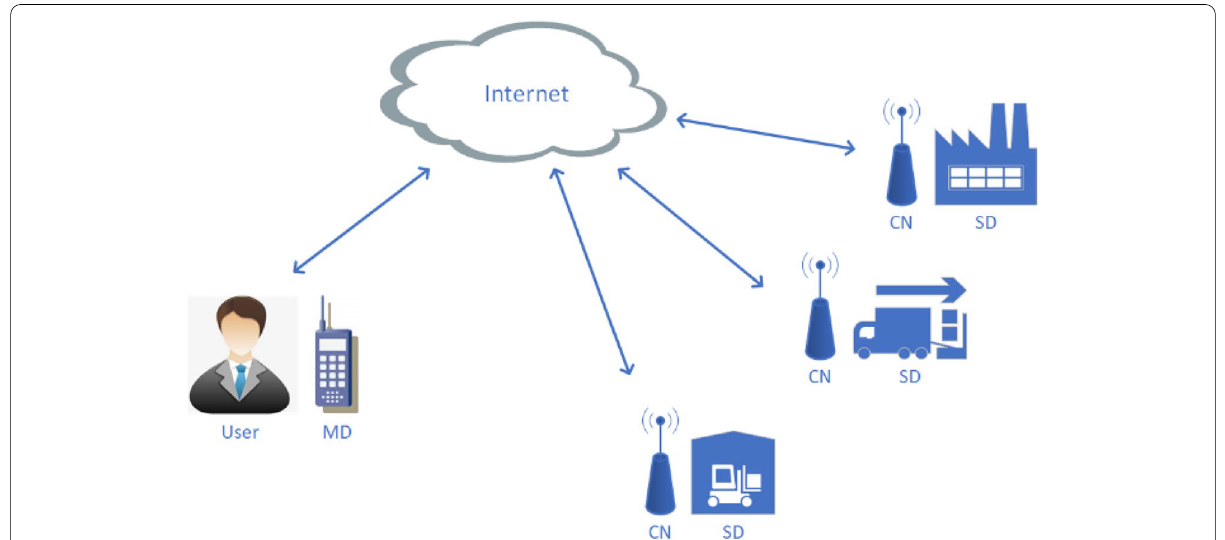
Fig. 1 A typical IS model in